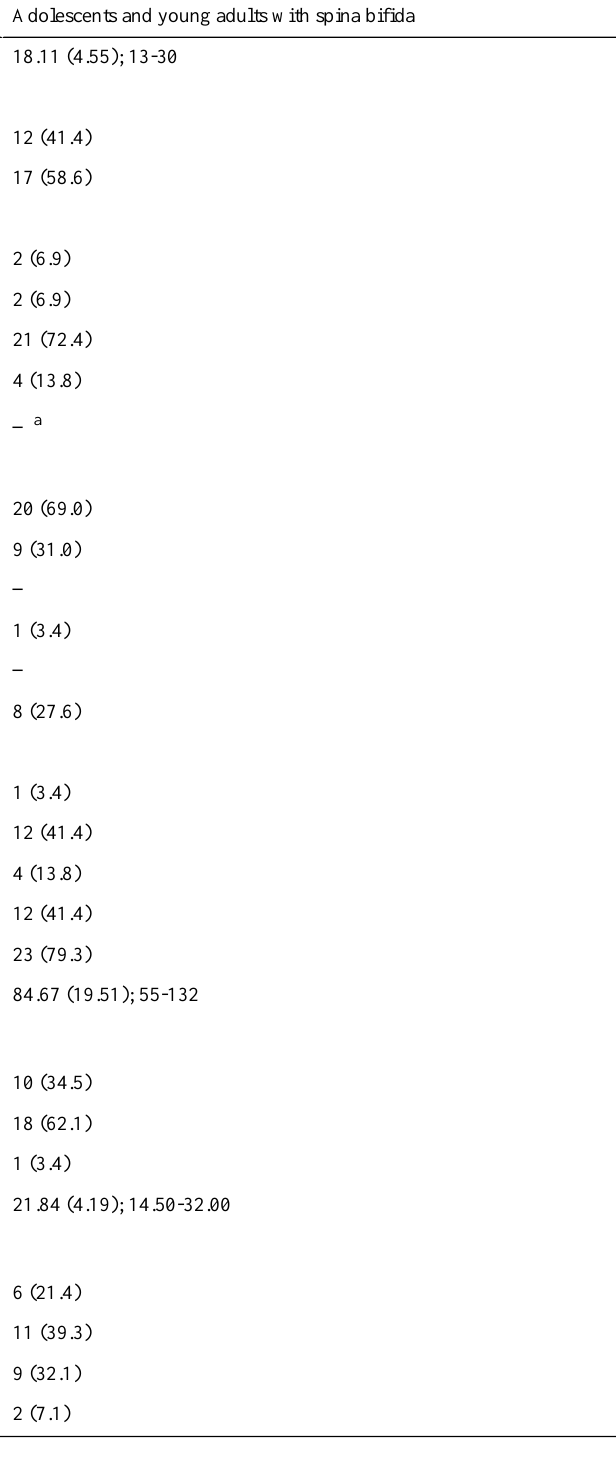
Table 1. Demographic, spina bifida, and health characteristics (N=29).